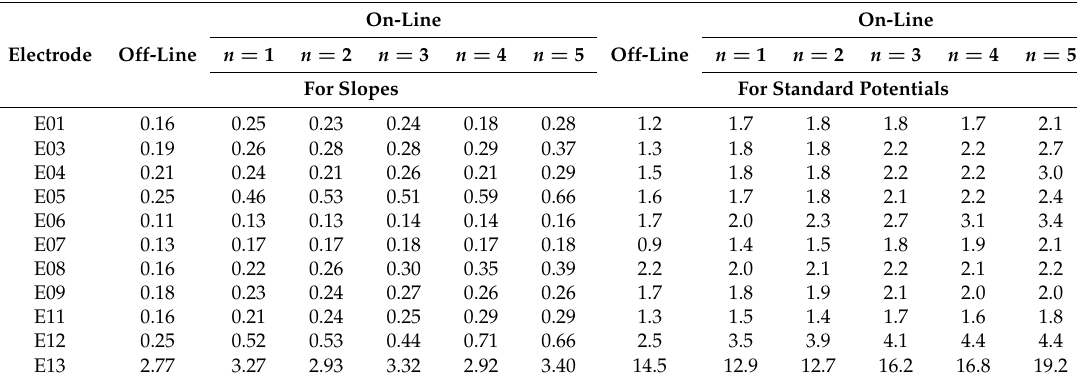
Figure 6. Illustration of performance of predictions for electrode E04: ( a ) electrode slope; ( b ) electrode standard potential; ( c ) slope residuals; and ( d ) standard potential residuals. Red stars are experimentally obtained electrode parameters (upper panels) or residuals (bottom panels), the red line is the off-line calculated approximation function, and color circles with lines are predicted values. Each line in a particular color implies that the same prediction parameters are used for predicting future values based on the past data. Table 5. Quality factors of predictions calculated for slopes and standard potentials. Off-line factors are standard deviations of differences between parameters obtained from calibration and from exponential approximation. On-line factors are standard deviations of differences between parameters obtained from calibration and from the prediction of future n values, where n is the number of future predictions. All values are expressed in